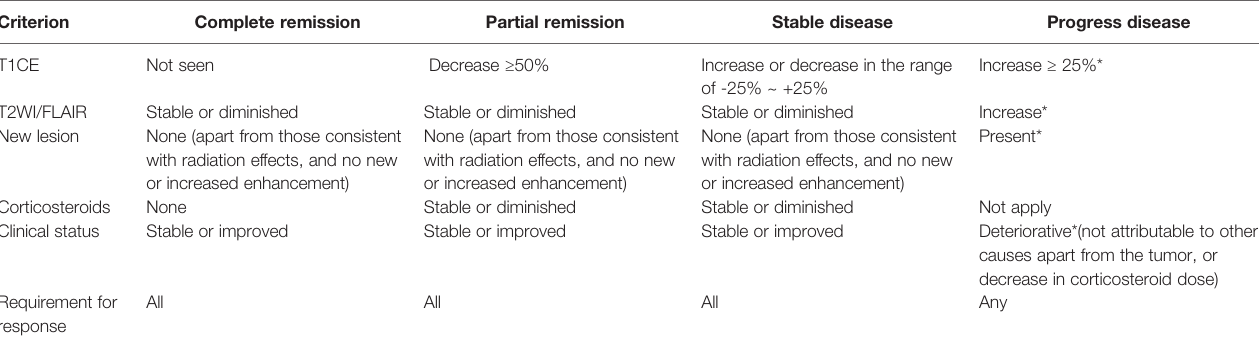
TABLE 1 | RANO criteria used to evaluate treatment response in low-grade